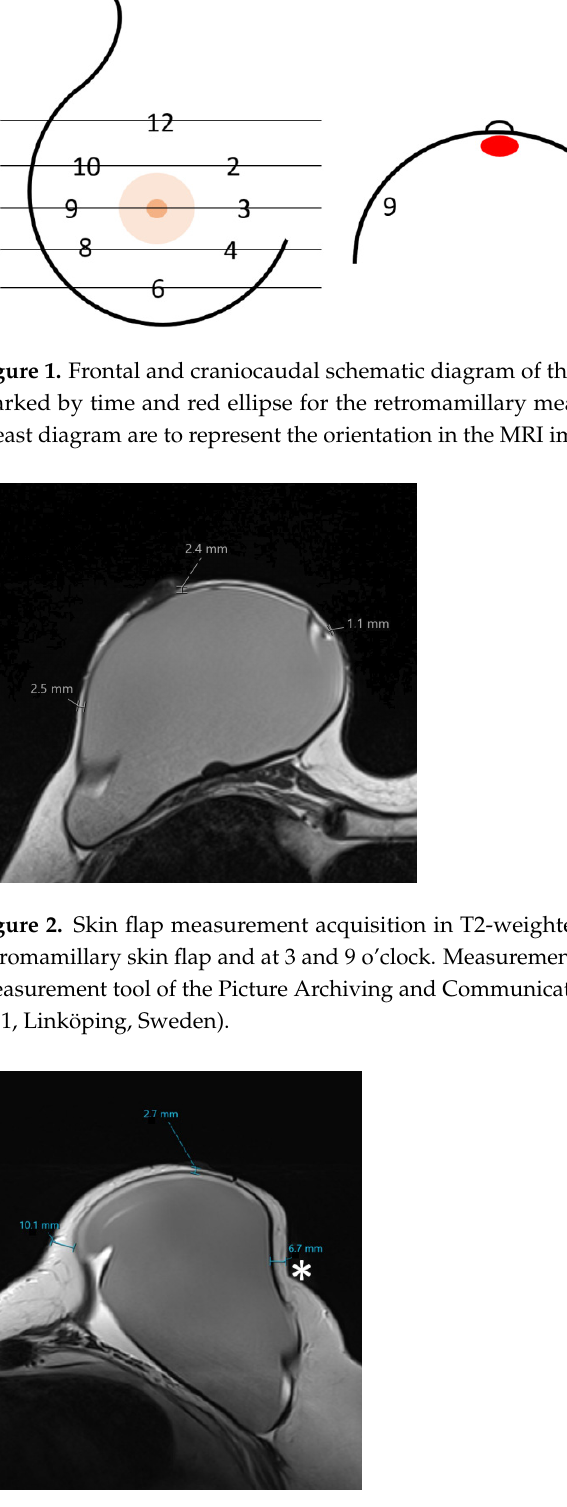
Figure 3. Example of compression (*) of the breast acquisition in T2-weighted image. Thickness measurements of retromamillary skin flap and at 3 and 9 o’clock. Measurements were performed using the integrated measurement tool of the Picture Archiving and Communication System (SECTRA AB, IDS7 Version 22.1, Linköping, Sweden).